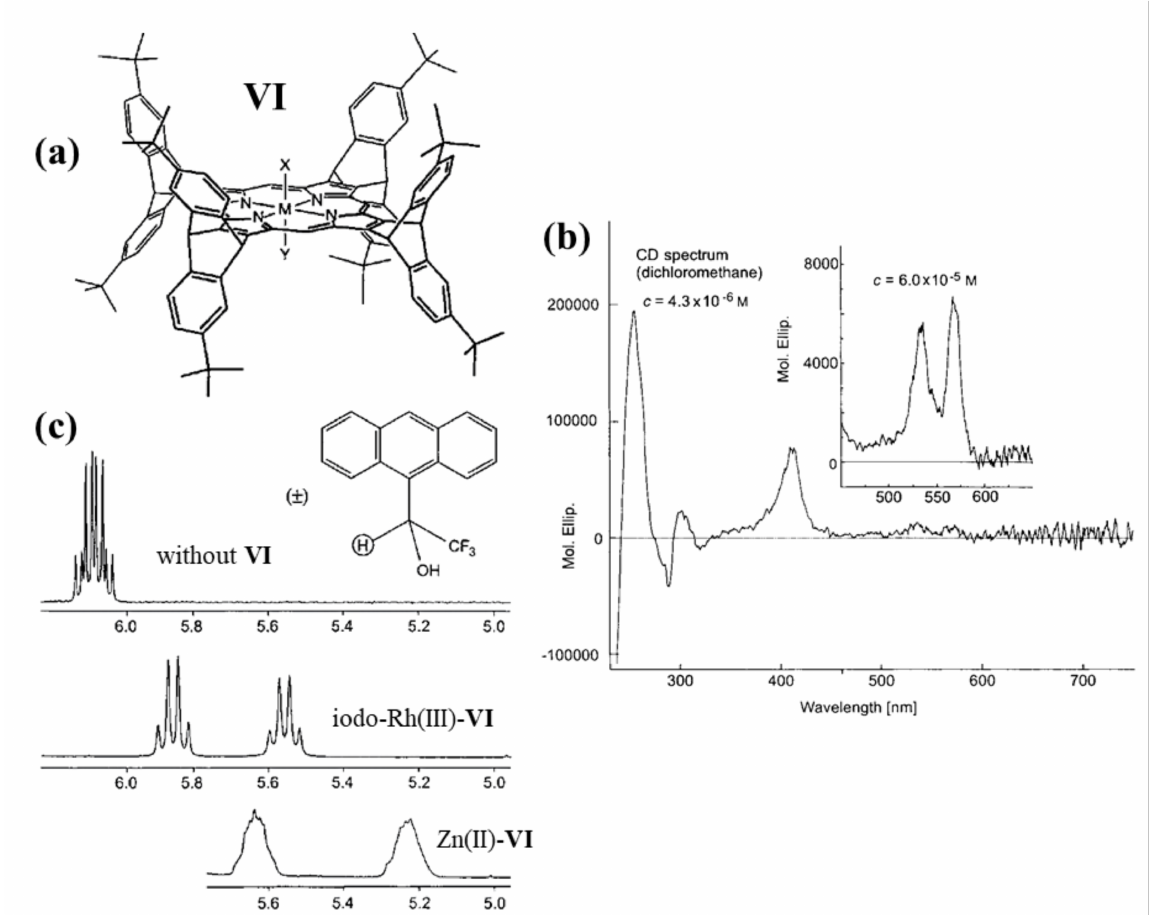
Figure 3. ( a ) Structure of biconcave metalloporphyrins with a rigid framework VI ; ( b ) CD spectra of biconcave Zn(II)- porphyrin VI in dichloromethane; ( c ) 1 H NMR shift experiments in C 6 D 6 of racemic 1-(9-anthryl)-2,2,2-trifluoroethanol in the absence (top) and presence (middle and bottom) of chiral bis-metalloporphyrins iodo-Rh(III)-porphyrin VI and Zn(II)-porphyrin VI . Adapted with permission from reference [61]; published by John Wiley and Sons